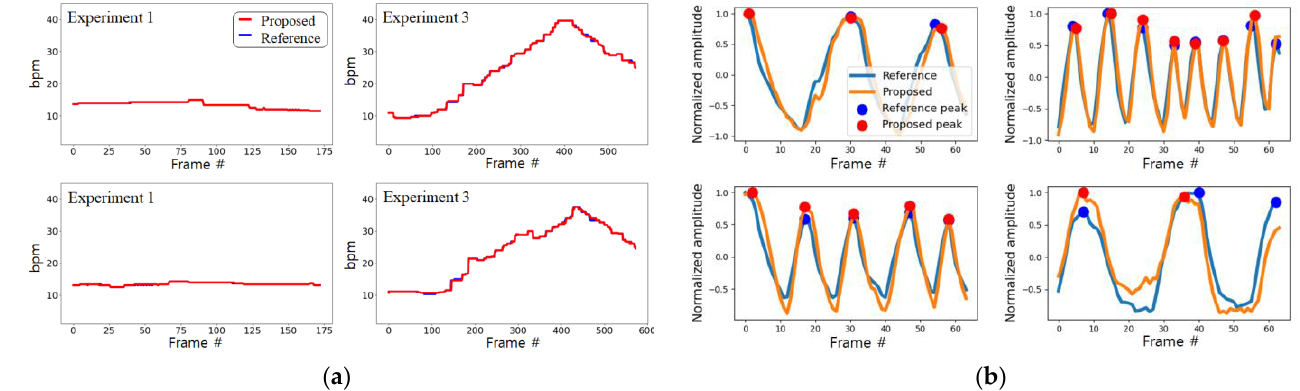
10 of 13 Table 1. Performance results for the overall data and each of the three experiments. Data